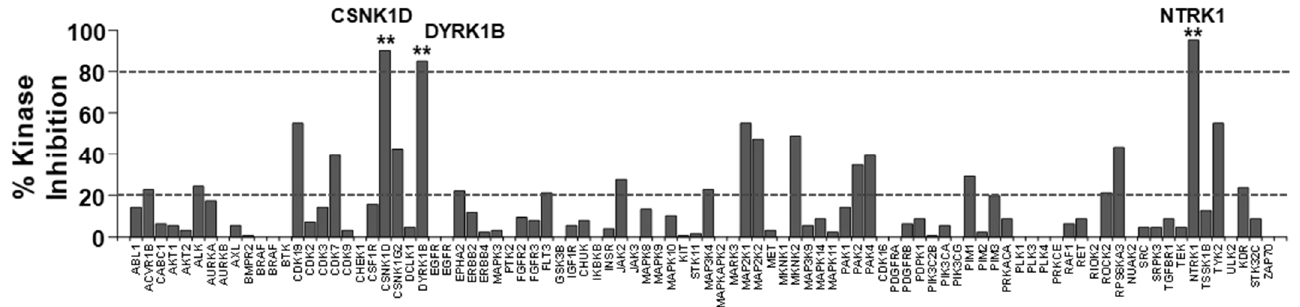
Figure 3. Kinase inhibition profile of compound 1g . Kinome scan assays were performed for compound 1g (1 µ M) against 96 kinases. **—strong inhibition of target kinases (<20% activity remaining).